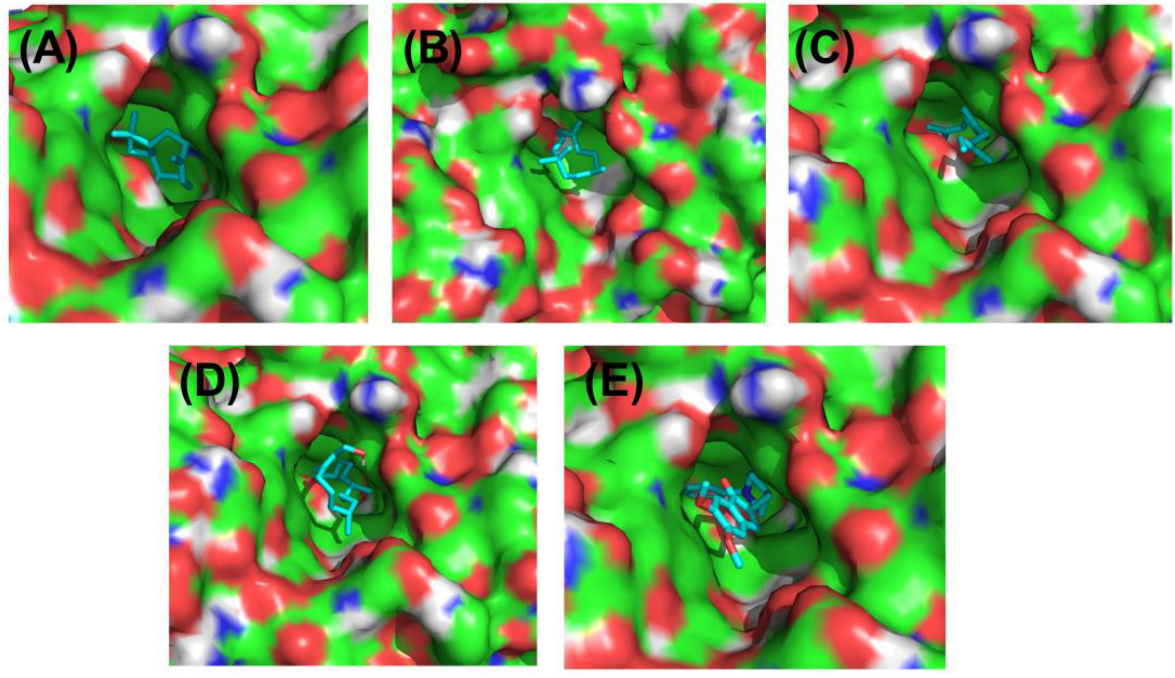
Figure 11. The binding pocket of all investigated compounds, cyan color representing the drugs ( A – E ) and green, red, blue, and white colors representing the active pocket site ( A ) caryophyllene, ( B ) humulene, ( C ) beta-farnesene, and ( D ) phytol in comparison to standard drug ( E ) donepezil using target acetylcholinesterase protein 1GQR.